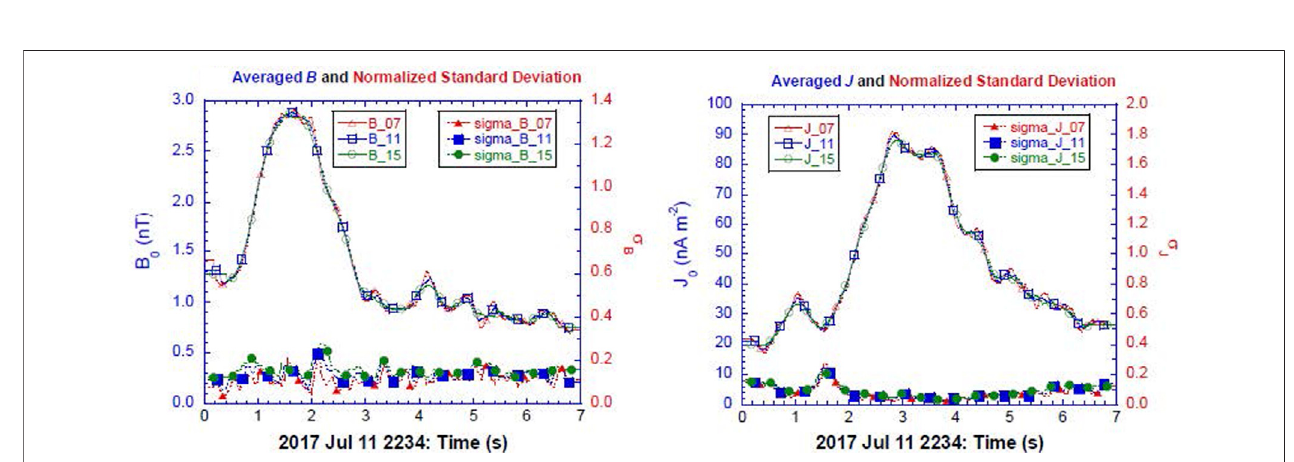
, J , J ) from FPI (Pollock et al., 2016) in GSE coordinates. x y z